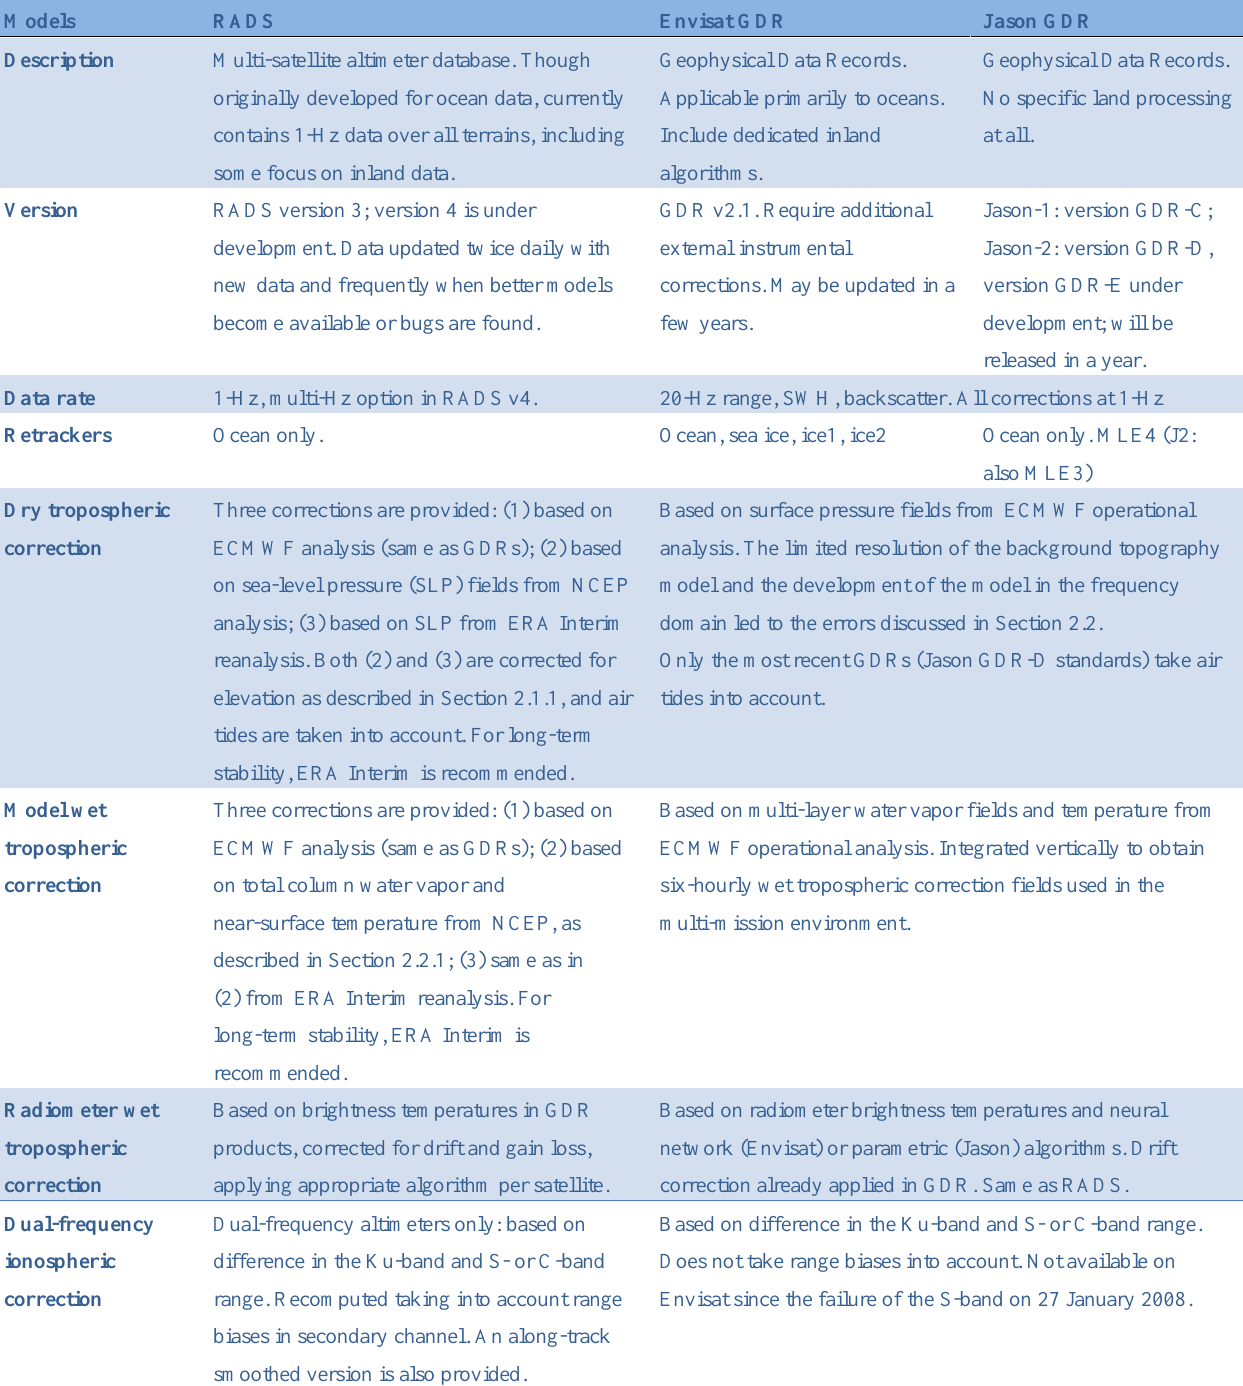
Table 1. Detailed description and comparison of the data fields contained in the Geophysical Data Records (GDR) products and RADS for the altimeters, Jason-1, Jason-2 and Envisat. ECMWF, Centre for Medium-Range Weather Forecasts; NCEP, National Centers for Environmental Prediction; JPL, Jet Propulsion Laboratory; TEC, total electron content; IRI, International Reference Ionosphere; NIC09, NOAA Ionosphere Climatology 2009; MLE3/MLE4, Maximum Likelihood Estimator retracking algorithms with 3 or 4 parameters; FES, Finite Element Solution tide models; GOT, Goddard Ocean Tide model; SWH, significant wave